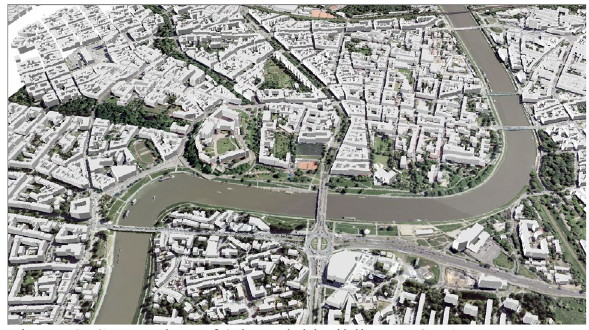
Figure 8. Screenshot of 3d model building-